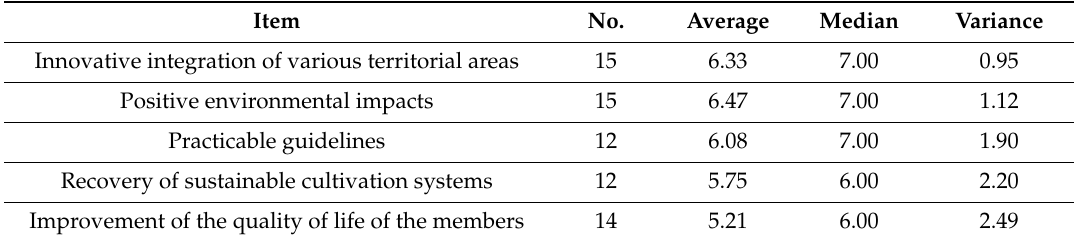
Table 3. Evaluation of the strengths of the land consolidation associations.